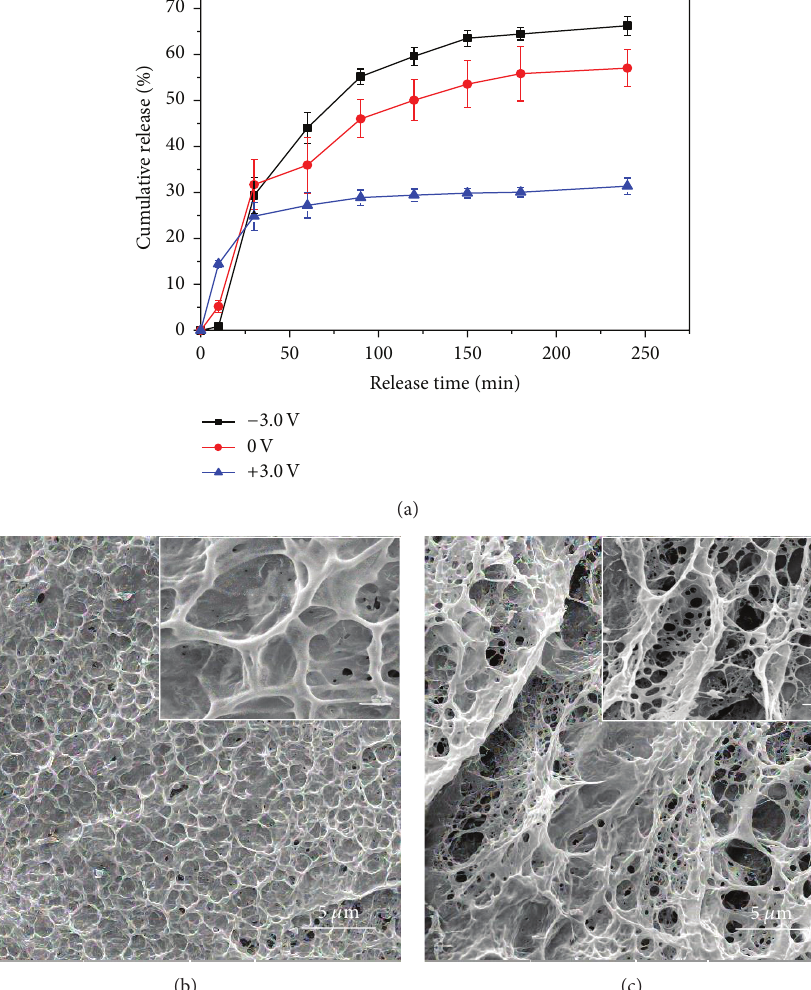
Figure 7: Cumulative release of ibuprofen from chitosan-ibuprofen hydrogels by applying external potentials (a) and SEM images of the chitosan hydrogel after ibuprofen release by applying − 3.0 V (b) and +3.0 V (c). The insert of SEM image shows high magnified images (the scale bar was 1 𝜇